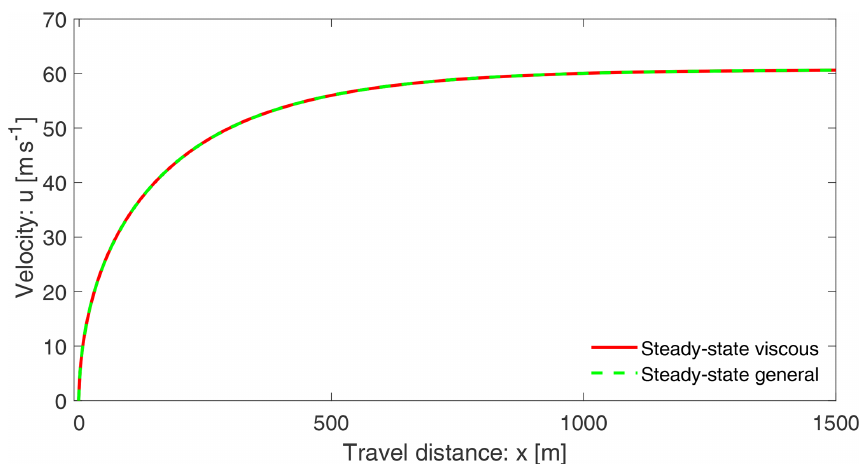
Figure 8. The velocity profile down a slope as a function of position for a landslide given by Eqs. (39) and (40) reduced to the steady state (Eq. 48) against the steady-state solution with viscous drag given by Eq. (8). They match